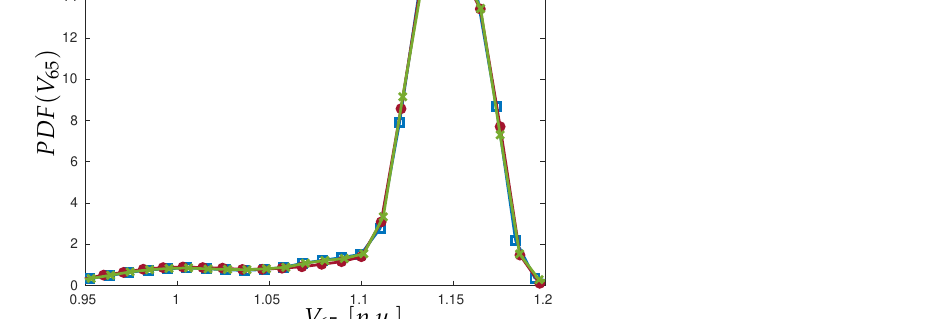
Figure 10. Detail of the PDF ( V 65 ) at Bus-65: (Square blue marker) computed with reference MC; (Dot red marker) computed with PWL method; (Green cross marker) computed with Copula and gPC (for expansion order β = 2).